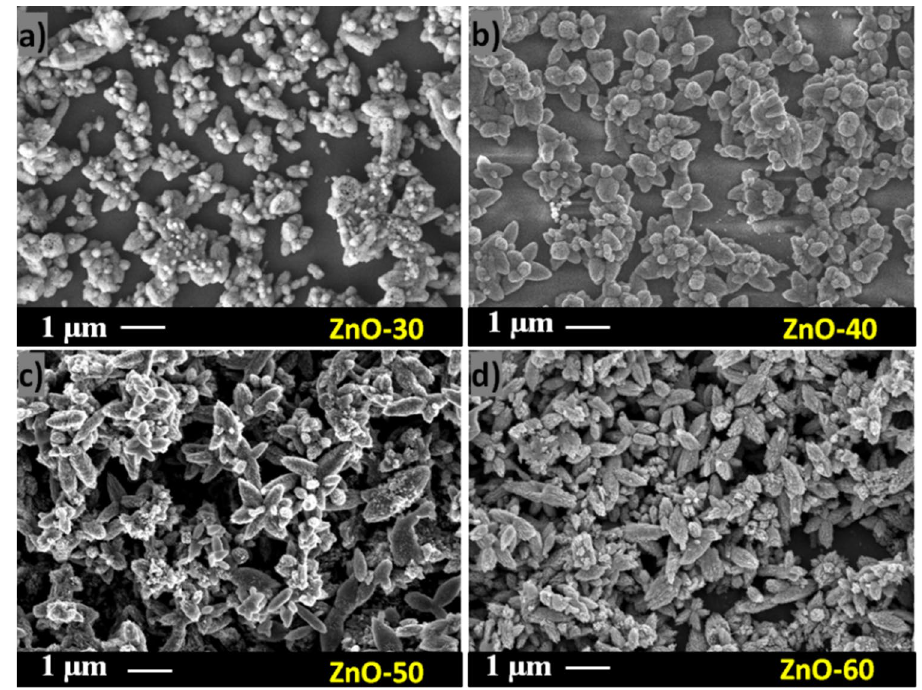
Figure 3. SEM images of the ZnO films grown in DW at ( a ) 30, ( b ) 40, ( c ) 50 and ( d ) 60